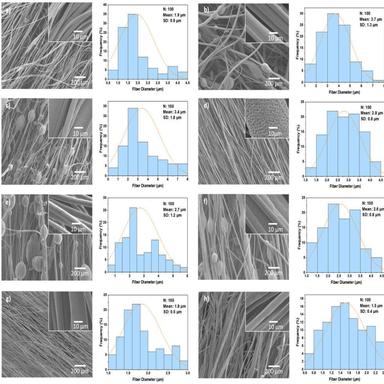
SEM micrographs of: a) 15 w/v % PEO, b) 15 w/v % PCL, c) PCL:PEO 14:1, d) PCL:PEO 4:1, e) PCL:PEO 2:1, f) PCL:PEO 8:7, g) PCL:PEO 2:3 and h) PCL:PEO 1:4, respective fiber diameter distributions all spun at 10 000 rpm, 0.1 MPa applied pressure.